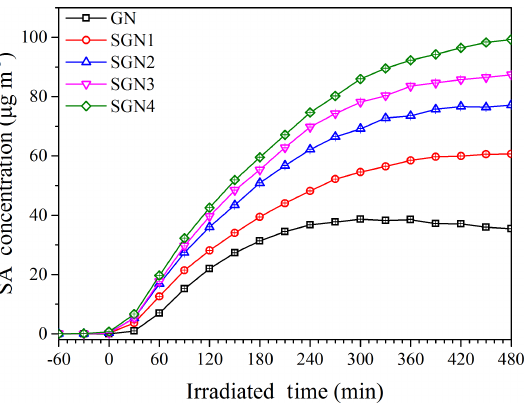
Figure 1. Time series of secondary aerosol concentrations during